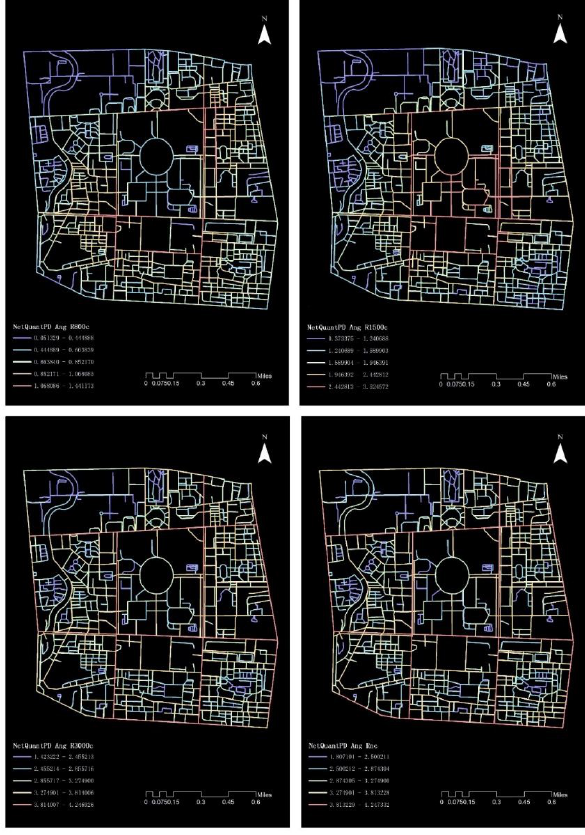
Fig. 1 Closeness degree of Tianhe Sports Centre and surrounding street network under different metric